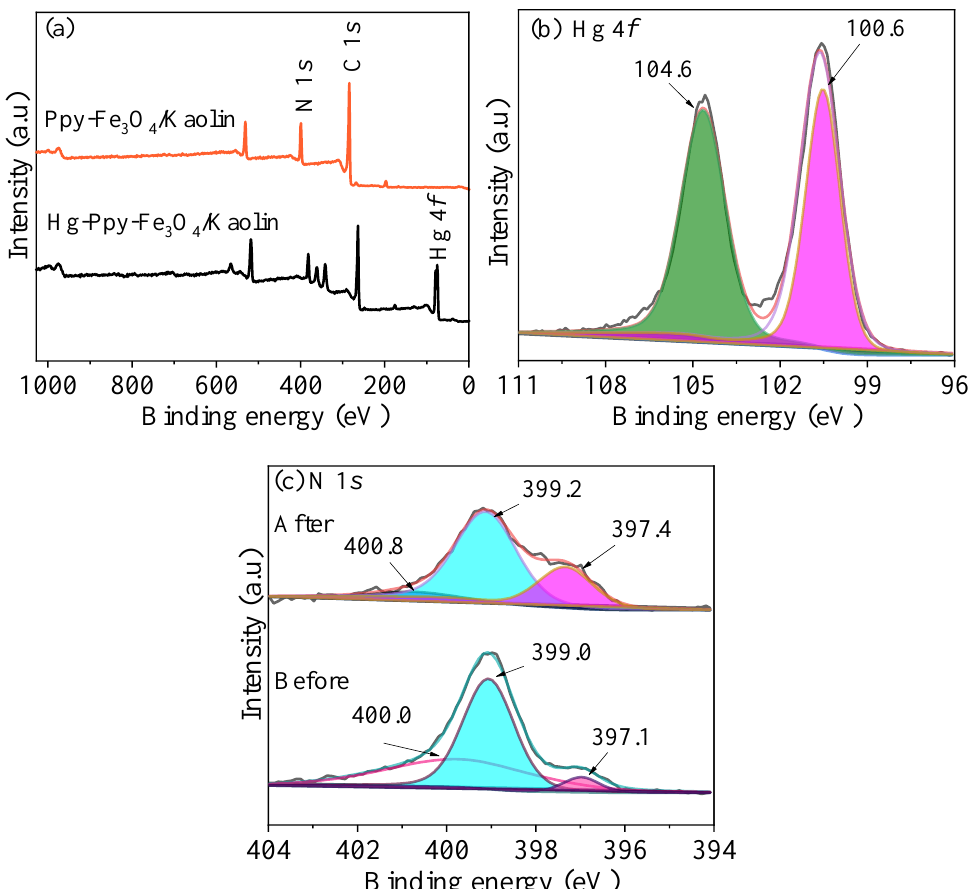
Figure 15. XPS spectra of ( a ) wide spectrum scan, ( b ) Hg 4 f and ( c ) N 1 s . Table 5. Changes in the composition of N element before and after adsorption.